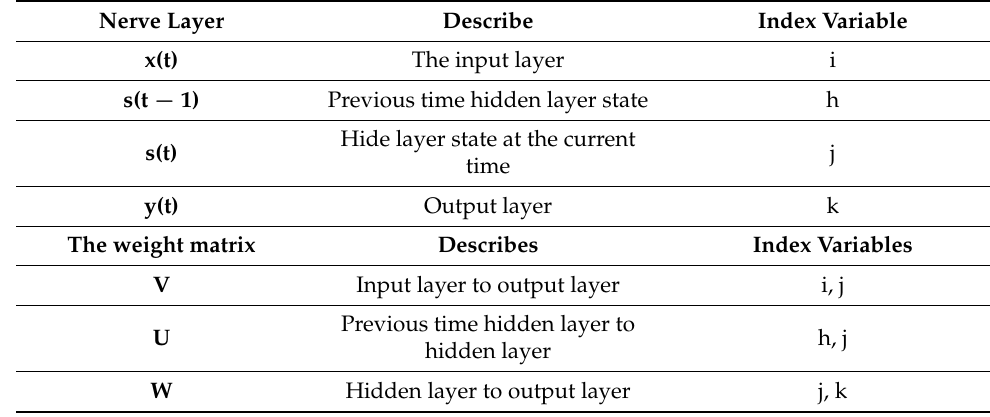
Table 2. Annotation definition table.